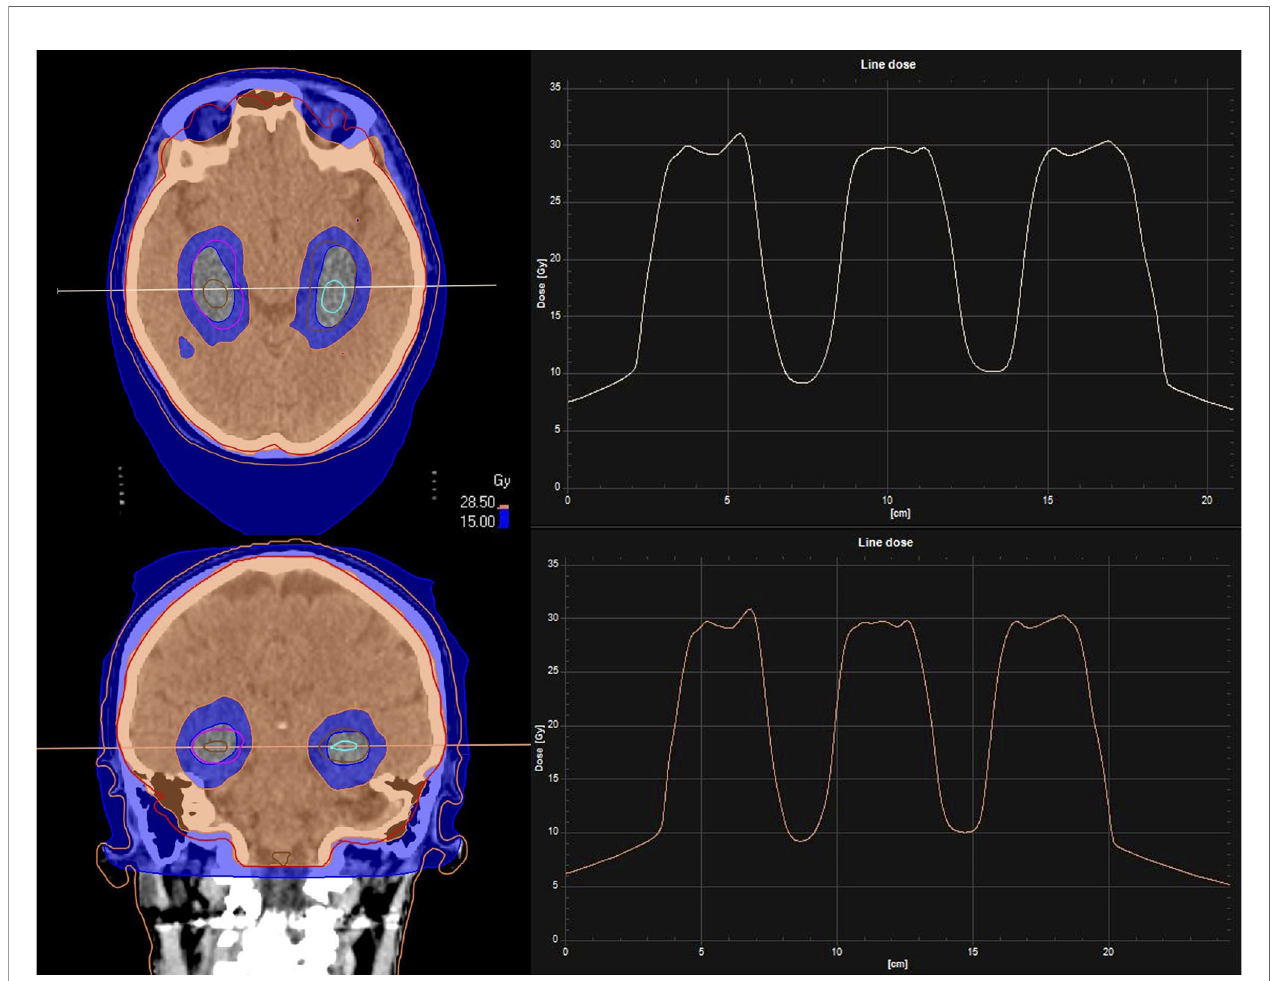
FIGURE 5 | Dose line of HA-WBRT: the dose line shows the drop in dose at the level of the hippocampi, and the rapid rise to the prescription dose of 30 Gy/10 fr in the surrounding areas included in the CTV of the